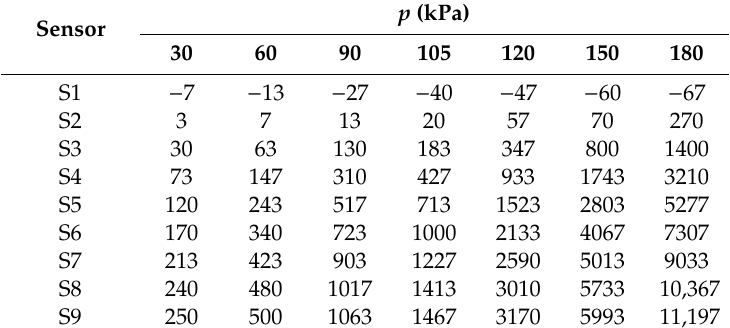
Table 2. The measured strain of each sensor for E6 (unit: µε ).